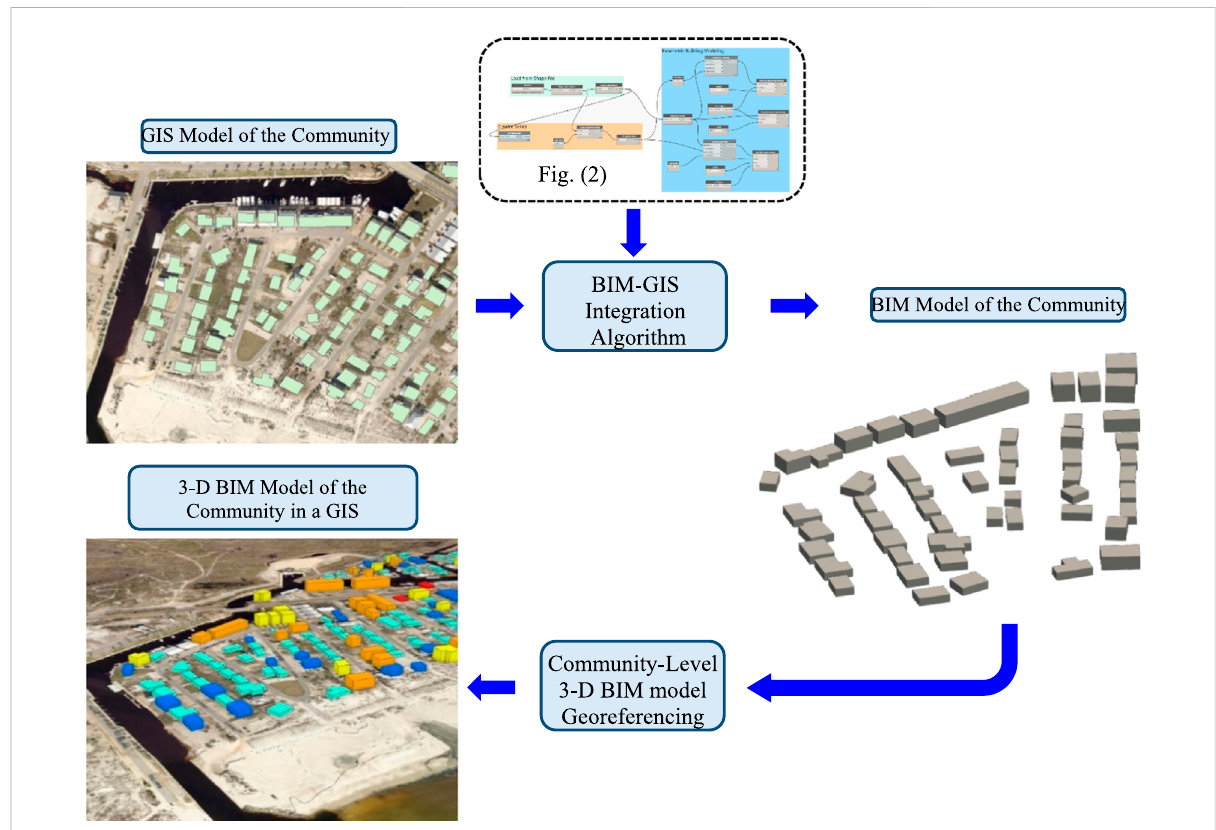
FIGURE 4 A schematic work fl ow to transform the 2-D GIS community model to a 3-D integrated BIM-GIS model of the